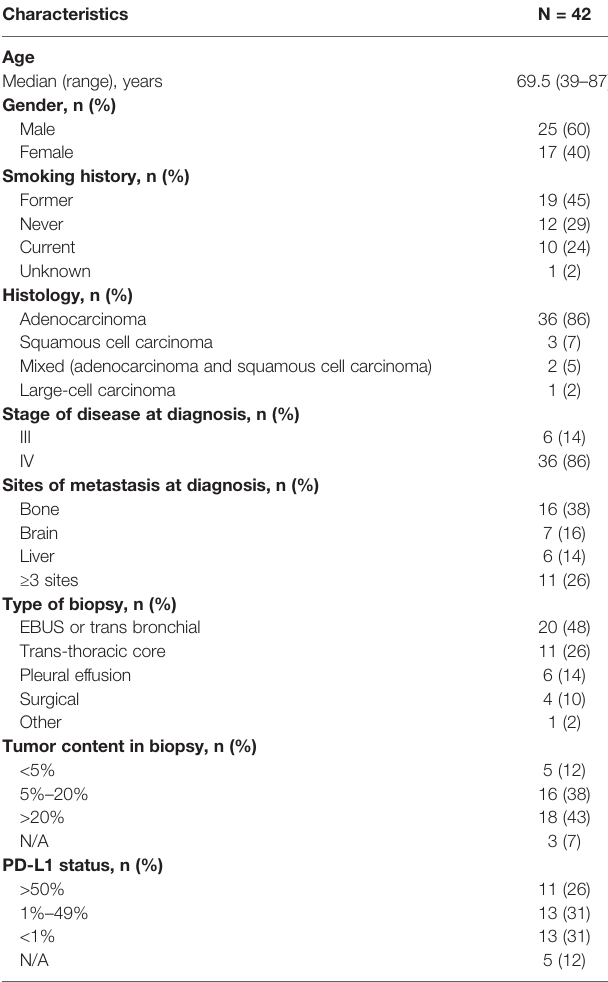
TABLE 1 | Baseline patient and tumor